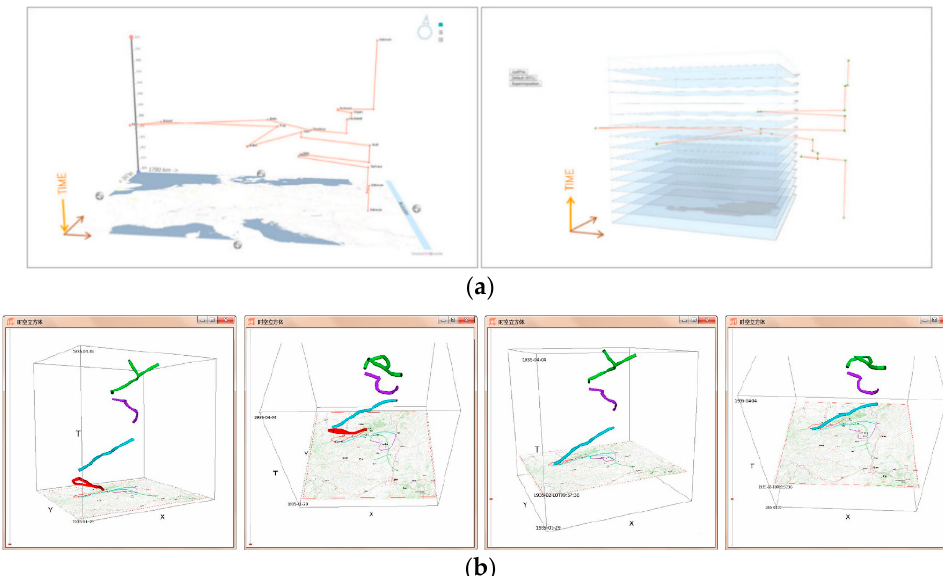
Figure 9. Applications of space–time cube interactions: ( a ) the Red Army’s Crossing the Chishui River Four Times [34]; and ( b ) life path of the Austro-Hungarian opera singer and director, Joszef Szabo [30].